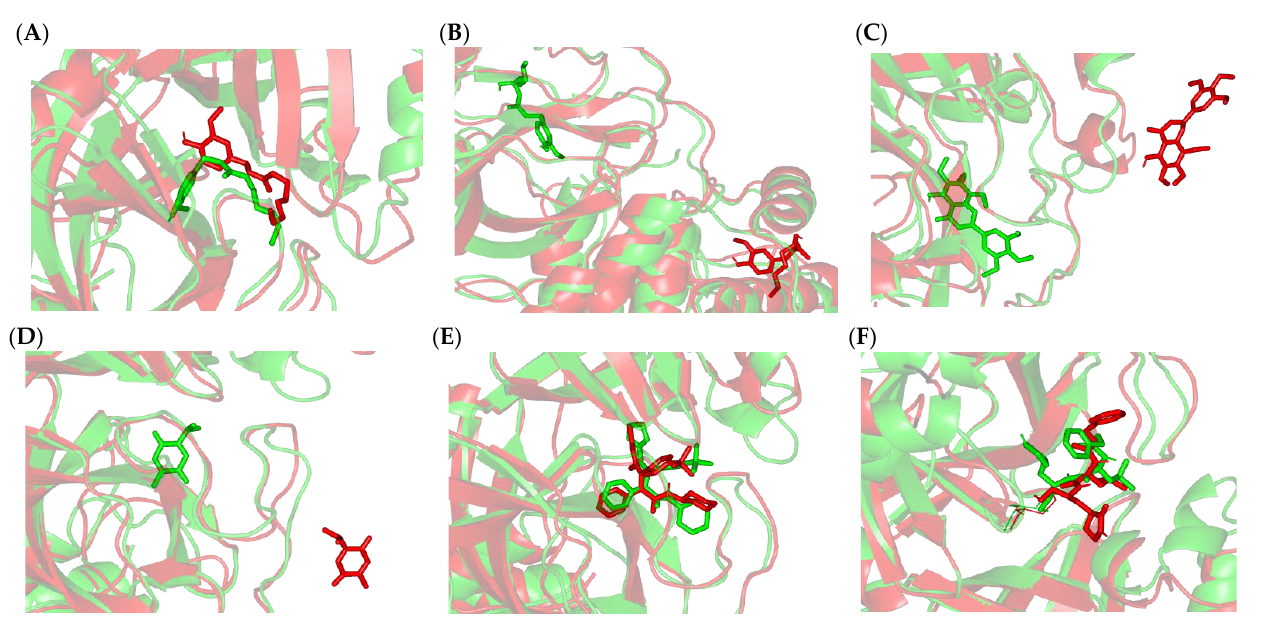
Figure 6. Conformational analysis of the simulated ligand-M PRO complexes at the start and end of the 100 ns explicit molecular dynamics simulation runs. ( A ) PAD; ( B ) GNG; ( C ) GDA; ( D ) THY; ( E ) X77; ( F ) GC376. Overlaid snapshots at 0 ns and 100 ns are presented in green and red colors, respectively; the target proteins (cartoon) and ligands (sticks) are colored corresponding to the extracted frame.